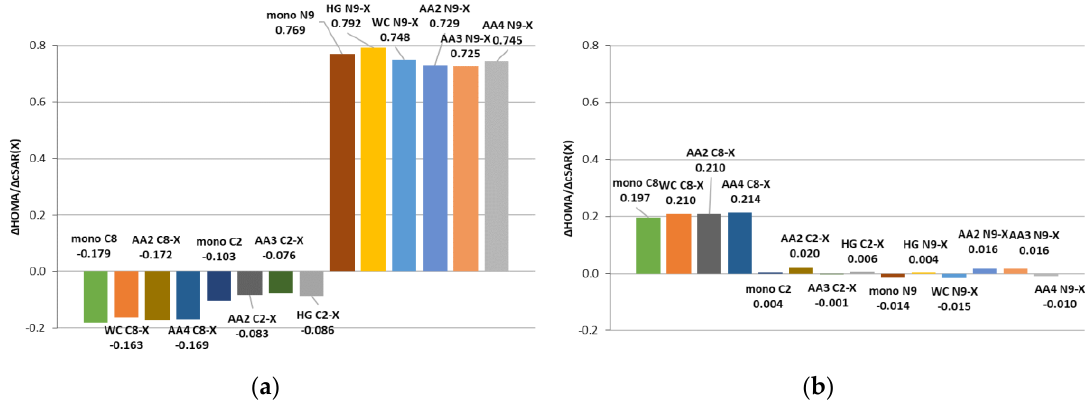
Figure 5. Influence of the substituents on Harmonic Oscillator Model of Aromaticity (HOMA) values for ( a ) five-membered ring and ( b ) six-membered ring in the studied base pairs, approximated by the slope ∆HOMA/∆cSAR(X) values, where ∆HOMA = HOMA(NH 2 ) − HOMA(NO 2 ) and ∆ c SAR(X) = c SAR(NH 2 ) − c SAR(NO 2 ).